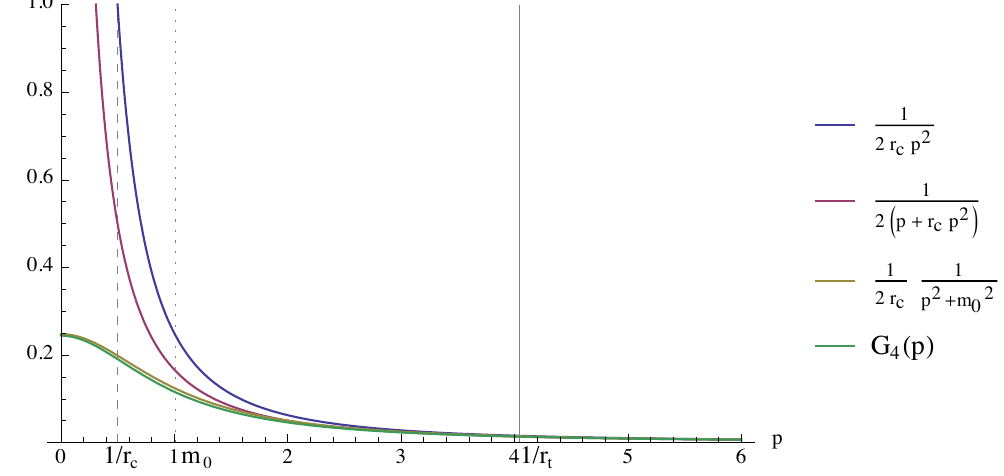
Figure 11 . The e(cid:11)ective brane-to-brane propagator for r t < r c . The vertical lines are from left to right: 1 =r c (dashed), m g (dotted), 1 =r t